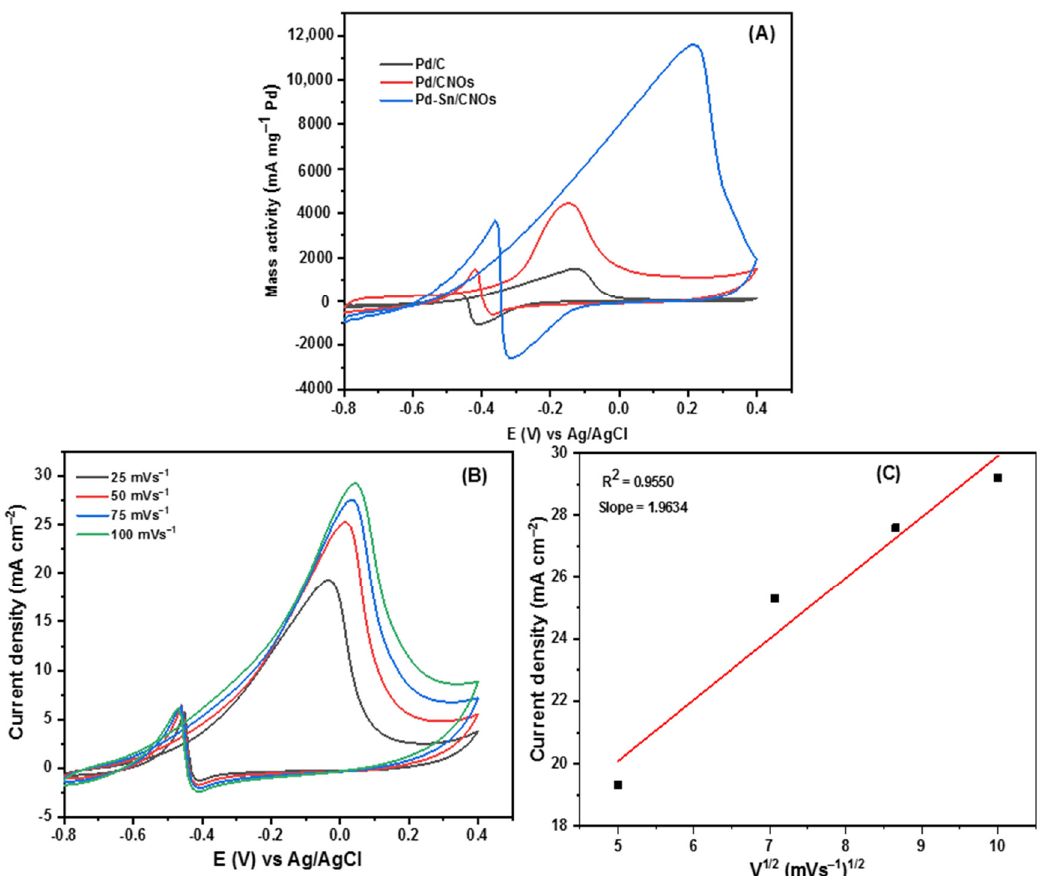
Figure 9. Cyclic voltammogram of Pd/C, Pd/CNOs, and Pd-Sn/CNOs in 1 M KOH + 1 M CH 3 CH 2 OH solution at a scan rate of 50 mVs −1 at room temperature ( A ). Cyclic voltammogram of Pd-Sn/CNOs electro-catalyst in 1 M KOH + 1 M CH 3 CH 2 OH at different scan rates ( B ) and the plot of peak current density vs. square root of scan rates ( C ).